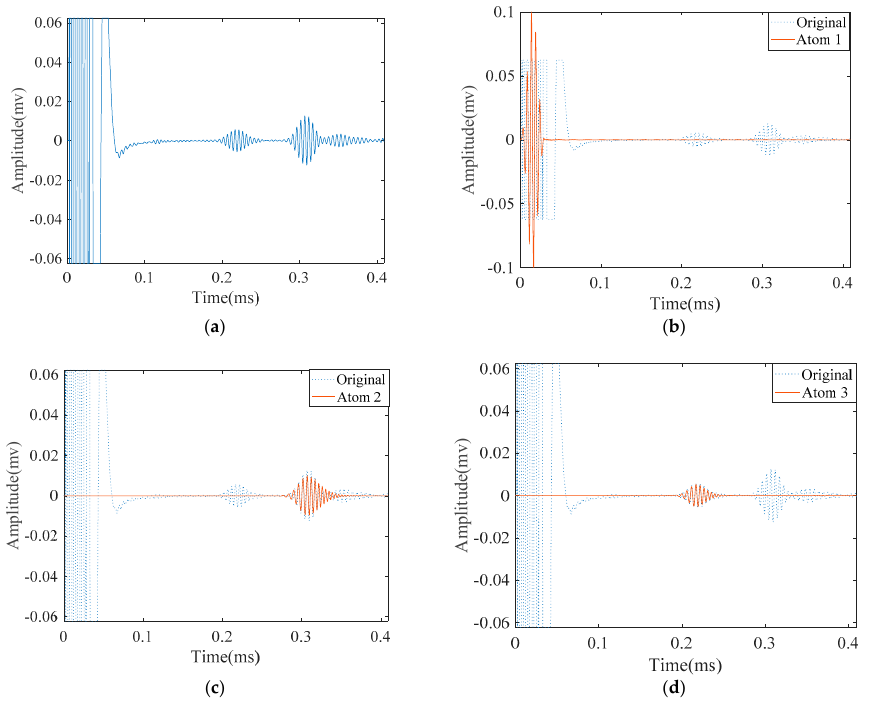
Figure 14. The experimentally measured signal in a cracked pipe and its approximation by SDMP: ( a ) the original measured signal; ( b ) approximated atom 1—the incident signal; ( c ) approximated atom 2—the reflection from the pipe end; and ( d ) approximated atom 3—the reflection from the crack. Materials 2017 , 10 , x FOR PEER REVIEW